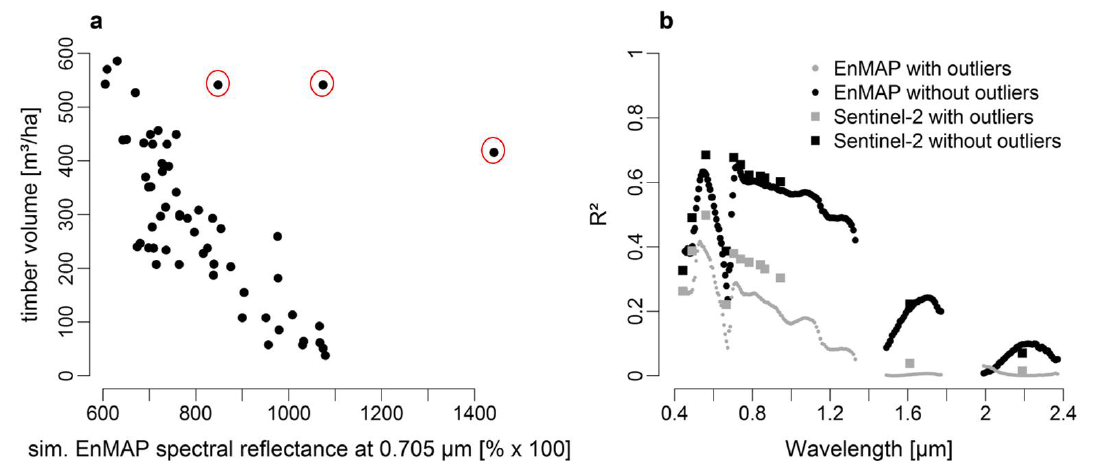
Figure 4. ( a ) Single band spectral response vs. timber volume, with identified outliers (red circles). ( b ) R² over the spectral range between 450 and 2500 nm for simulated EnMAP and Sentinel-2 data before (gray) and after (black) elimination of the